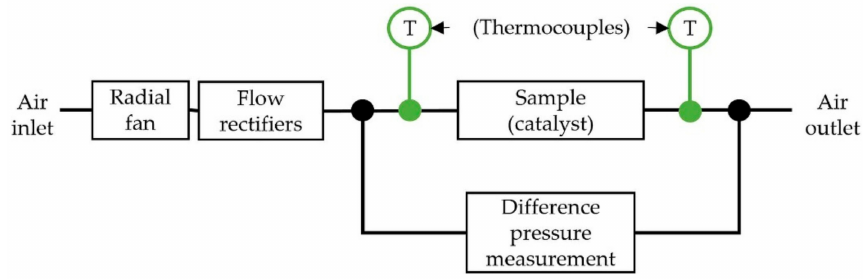
Figure 10. Schematic diagram of the test